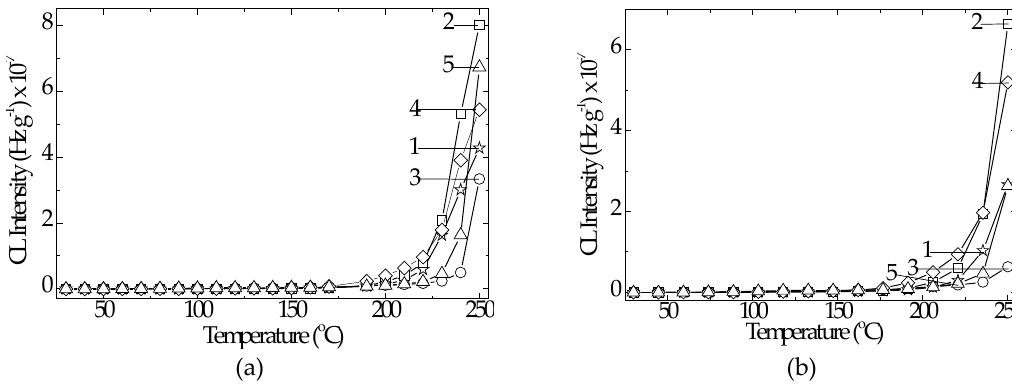
Figure 5. Non-isothermal CL spectra record on the thermally unprocessed LDPE/UHMWPE samples. Heating rates: ( a ) 10 °C min − 1 ; ( b ) 15 °C min − 1 . Indices denote the following: (1) LDPE/UHMWPE, (2) LDPE/HAp, (3) LDPE/HAp/RM, (4) LDPE/UHMWPE/HAp, (5) LDPE/UHMWPE/HAp/RM.